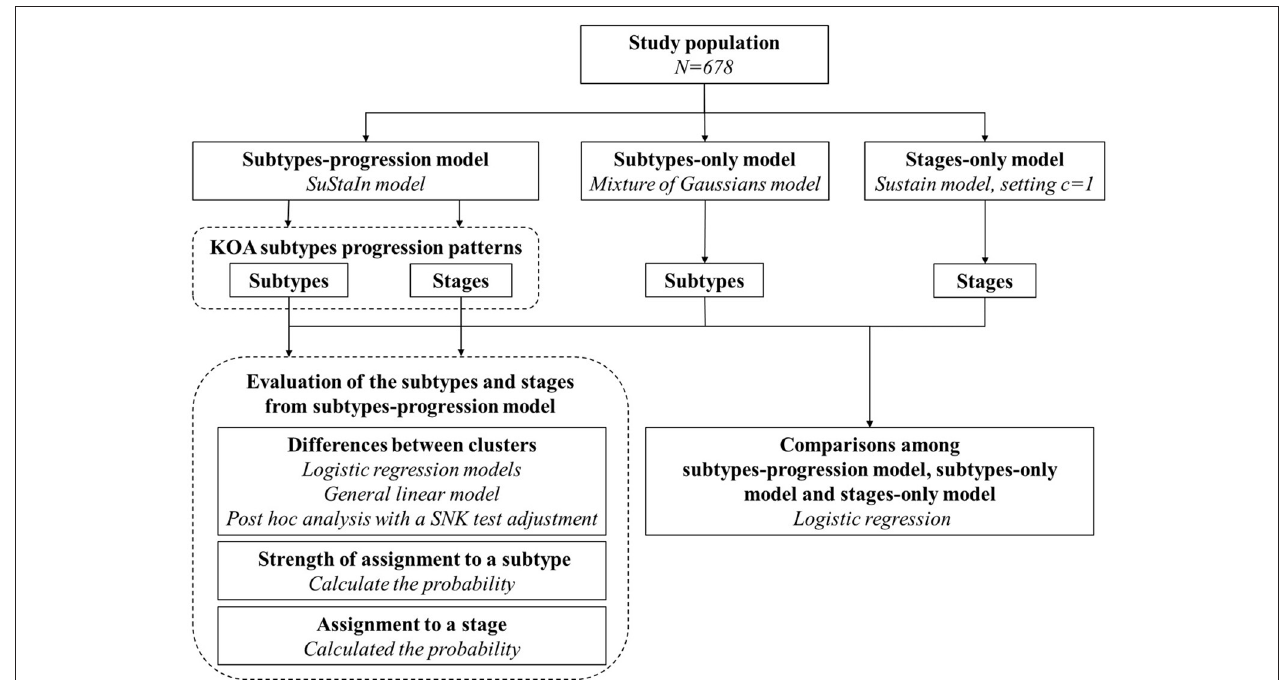
FIGURE 1 | Study roadmap for our